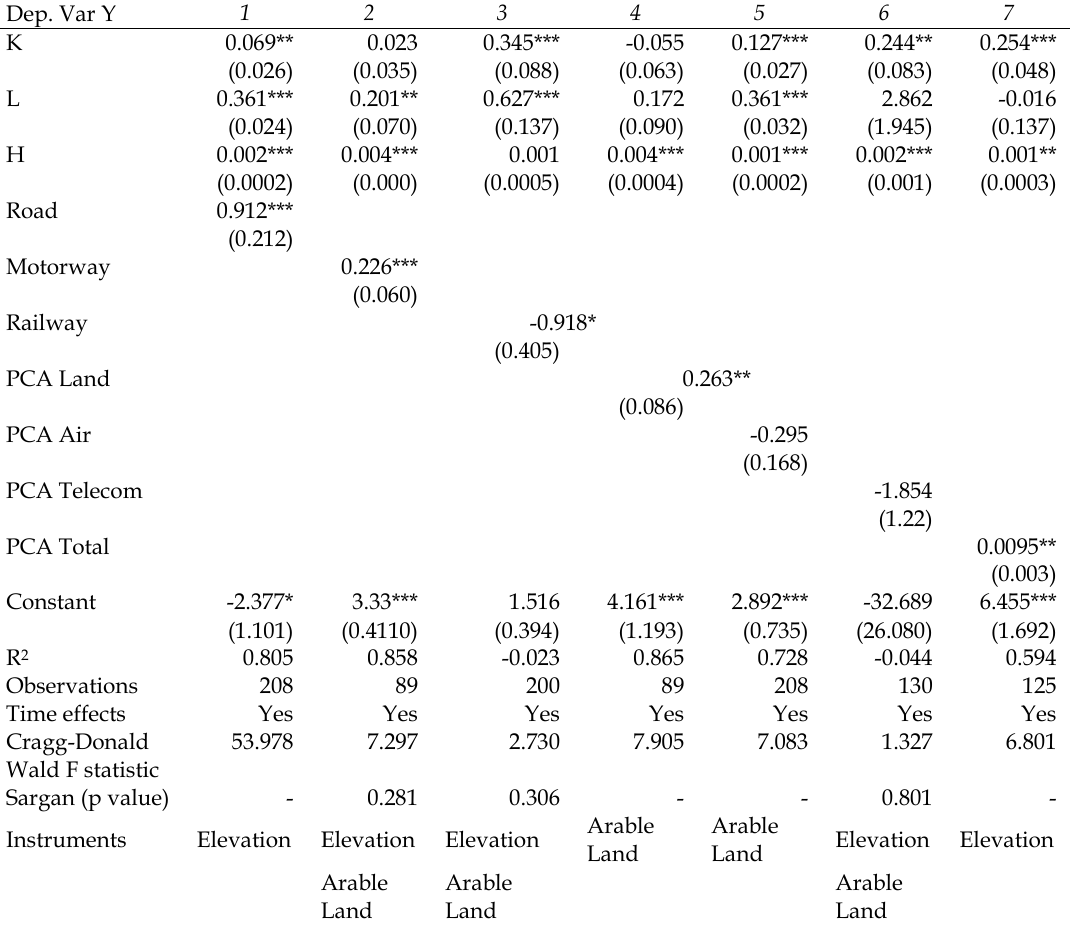
Table 6. Results of the 2SLS estimation